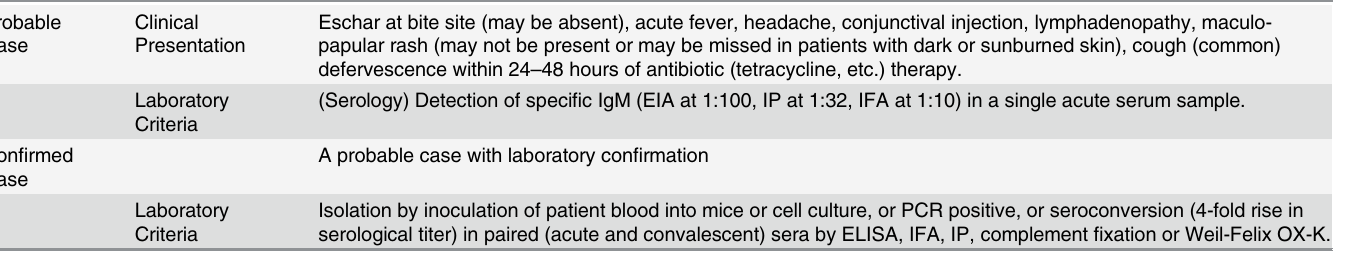
Table 1. Criteria used to score patient diagnosis of scrub typhus applied to each publication.